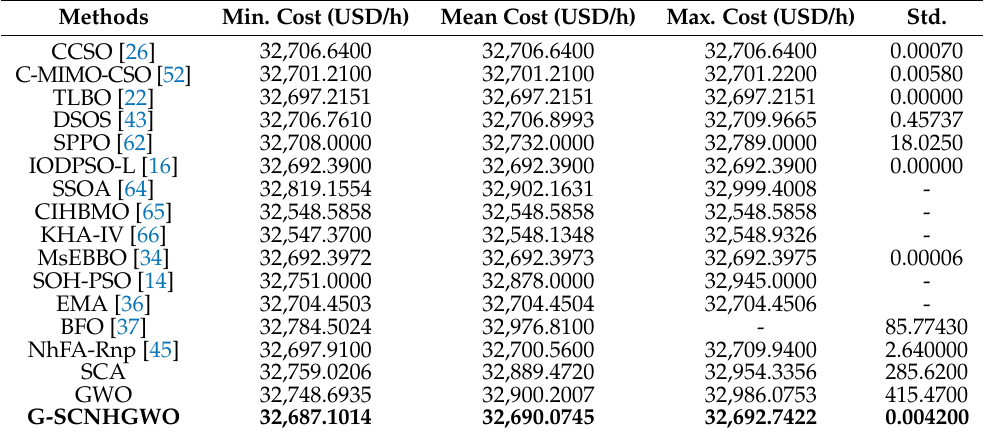
Table 6. The statistical indices of optimal results obtained by different algorithms in Case B-type 2.